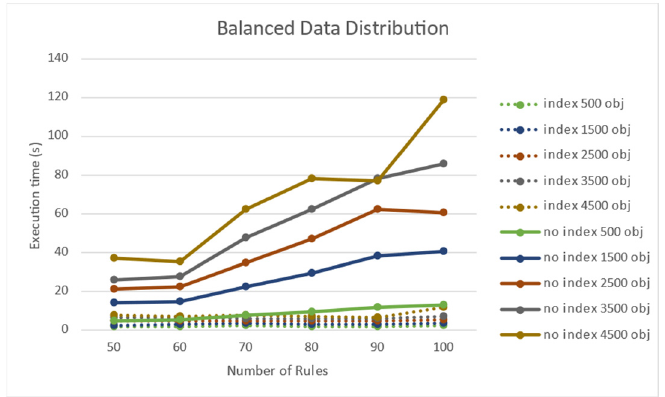
Figure 12. Performance effect of the number of rules on a uniform object distribution.